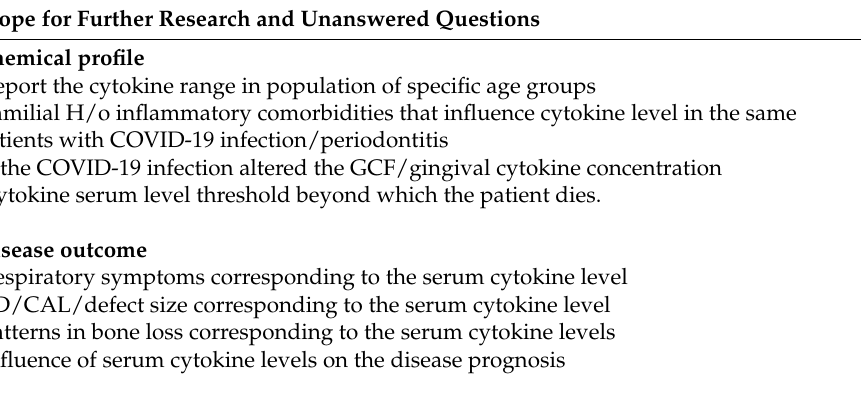
Table 4. Scope for further research and unanswered